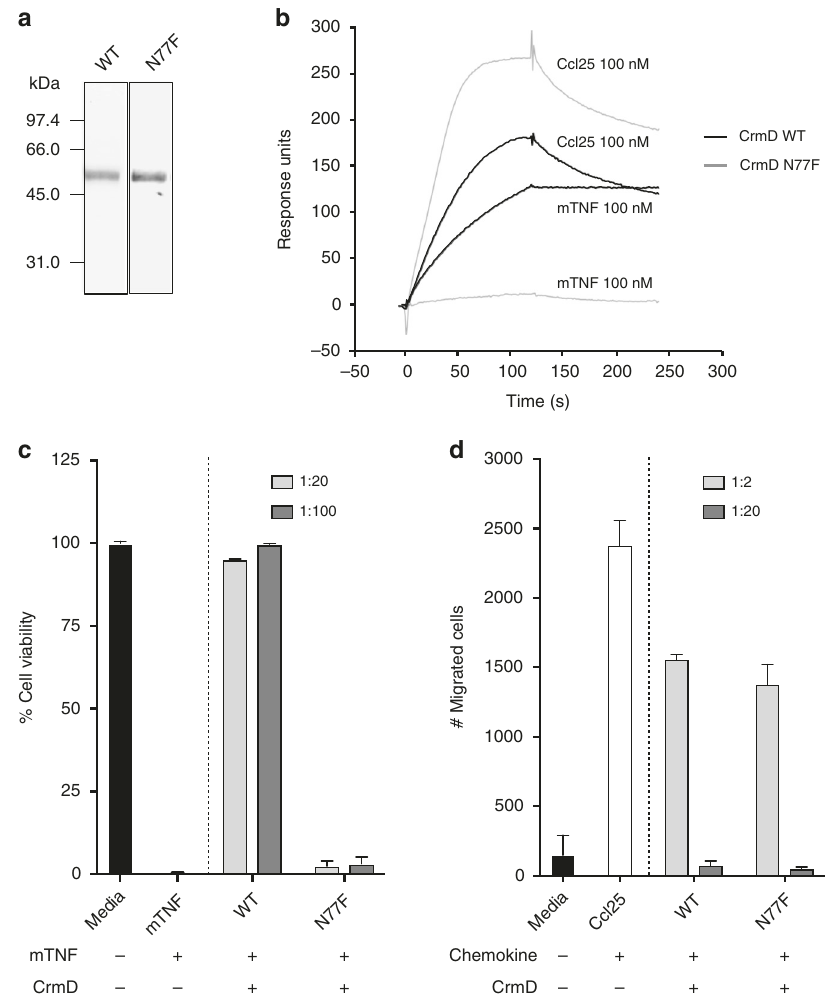
Fig. 6 CrmD N77F mutant blocks chemokines but lacks anti-TNF activity. a Coomasie blue stained gel showing 500 ng of recombinant CrmD wild type (WT) and N77F mutant expressed by recombinant baculoviruses. Molecular mass standards are shown in kDa. b CrmD N77F binds mouse Ccl25 but not mouse TNF (mTNF). The binding of 100 nM Ccl25 and mTNF to CrmD WT or N77F mutant was assessed by SPR experiments. c CrmD N77F mutant does not interfere with mouse TNF-mediated cytotoxicity on L929 cells. The cell viability of L929 cells after a 18 h incubation with 1.2 nM TNF in the absence or presence of the indicated molar ratios of CrmD variants was determined. Data is represented as mean ± standard deviation (SD) of the % relative to cells incubated without TNF (media). d CrmD N77F blocks mouse Ccl25-induced migration of MOLT-4 cells. The number of cells that migrated through the transwell fi lter after 4 h incubation at 37 o C with 50 nM mouse Ccl25 in the absence or presence of the indicated increasing molar ratios of CrmD variants is shown. Data is represented as mean ± SD of triplicates. In c and d , one experiment representative of three independent experiments is